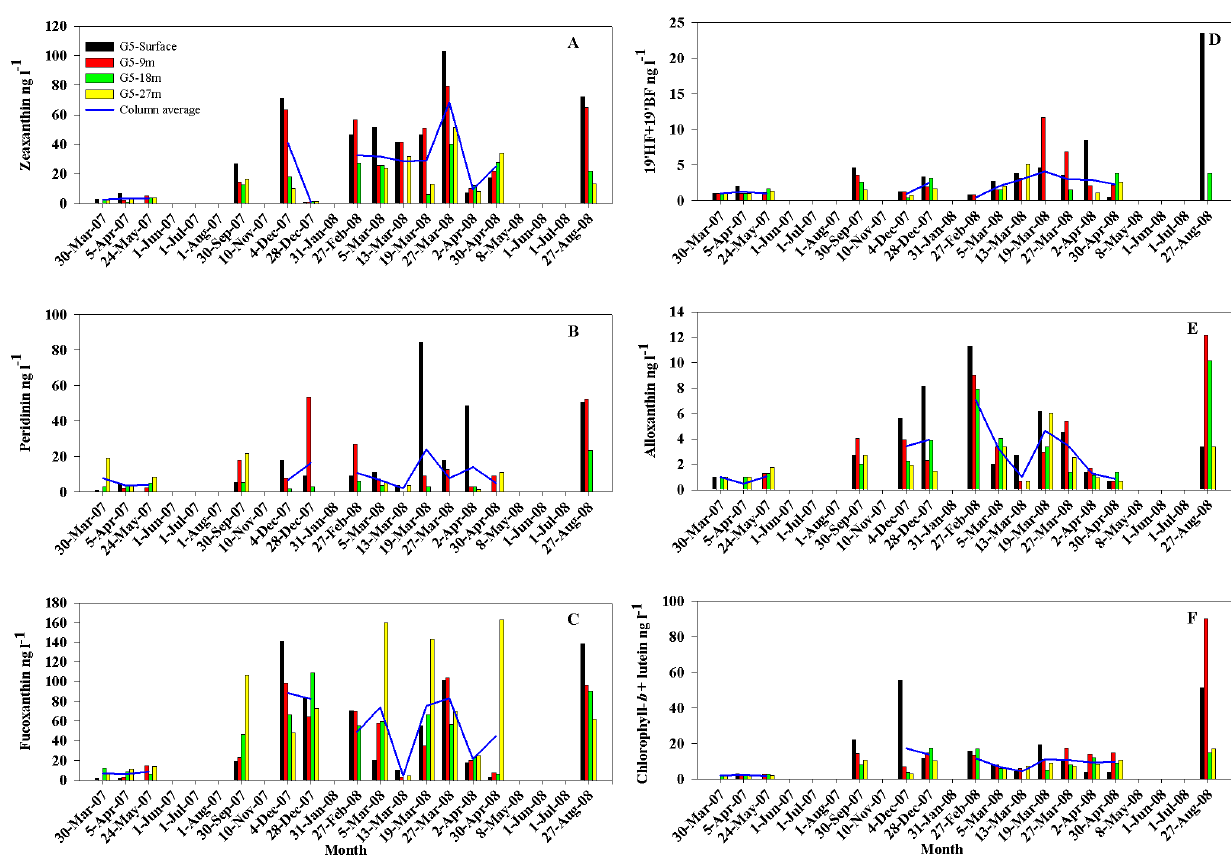
Fig. 4. Intra-annual variations of Zeaxanthin (A) , Peridinin (B) , Fucoxanthin (C) , 19’-hexanoyloxyfucoxanthin (19’HF) + 19’- butanoyloxyfucoxanthin (19’BF) (D) , Alloxanthin (E) , Chlorophyll- b + lutein (F) at the CaTS site from March 2007 to September 2008. The bold blue line represents column-averaged values (0m, 9m, 18m and 27m) for each parameter.